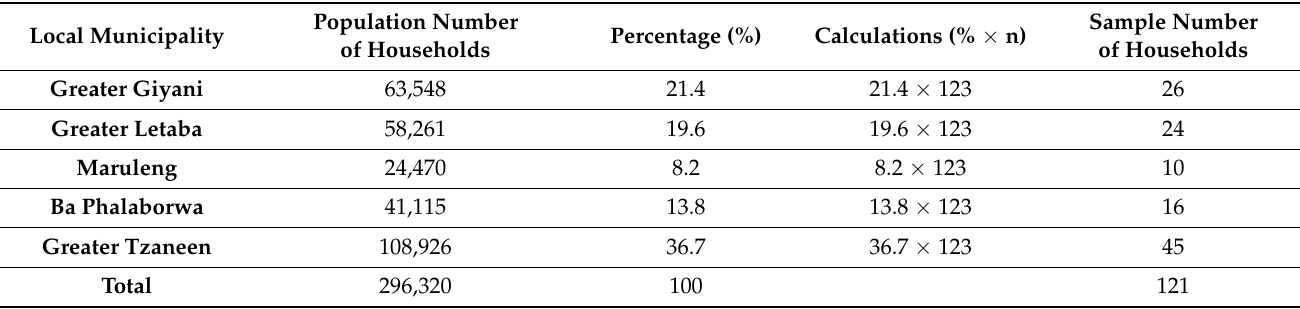
Table 4. Households Sampling.